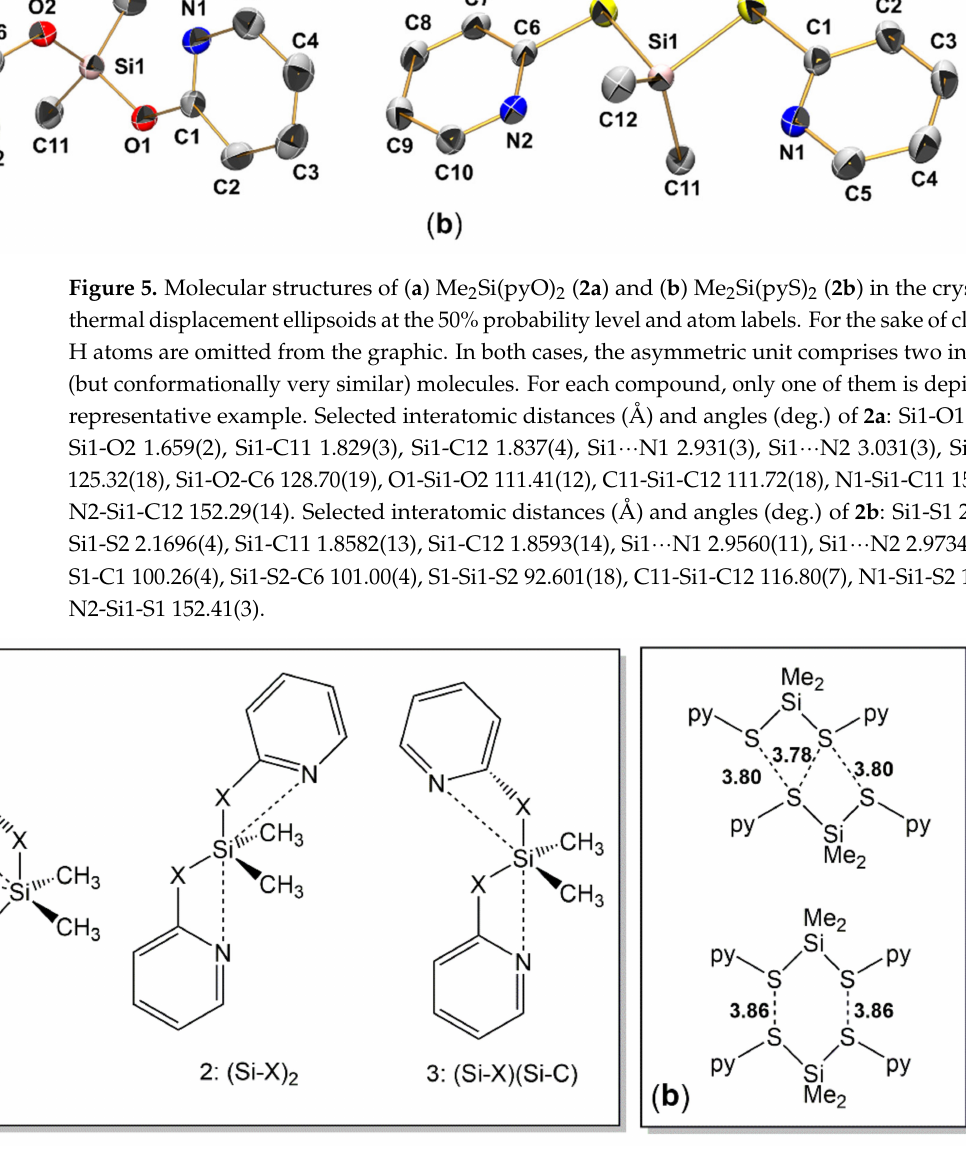
Figure 6. ( a ) Different conformers of compounds 2 (i.e., of the type Me 2 Si(pyX) 2 with X = O, S) with [4+2]-coordinate Si atom. The codes in parentheses indicate the trans bonds to the N → Si capped tetrahedral faces; ( b ) two different modes of weak intermolecular S ··· S contacts for molecule 1 (top) and molecule 2 (bottom) of 2b in the crystal packing with S ··· S separations in